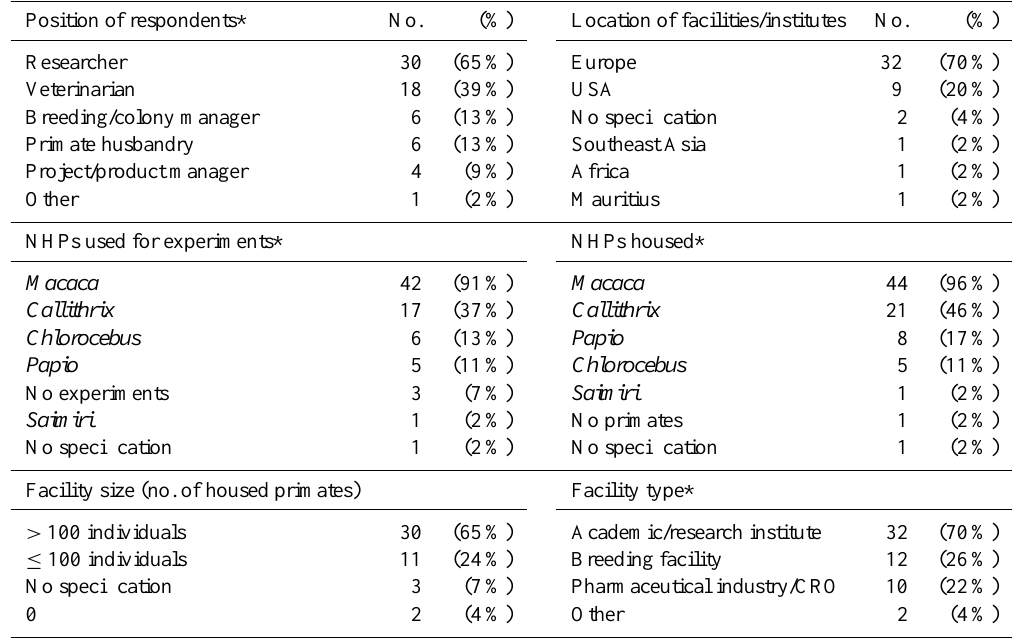
Table 1. Characterization of respondents and represented facilities ( N = 46). Position of